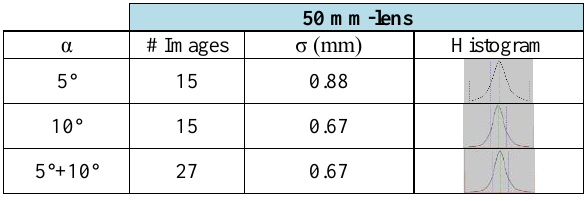
Table 4. Results obtained in the ISO 1 Laboratory.